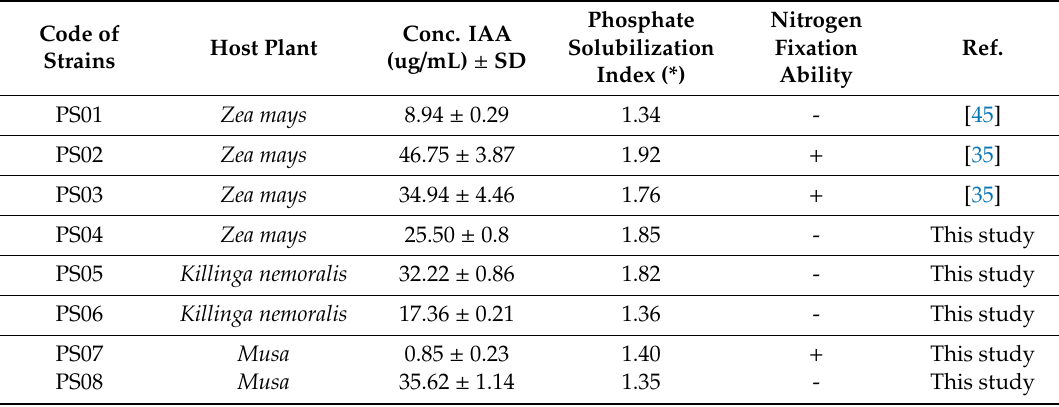
Table 1. Plant growth promoting characters of bacteria